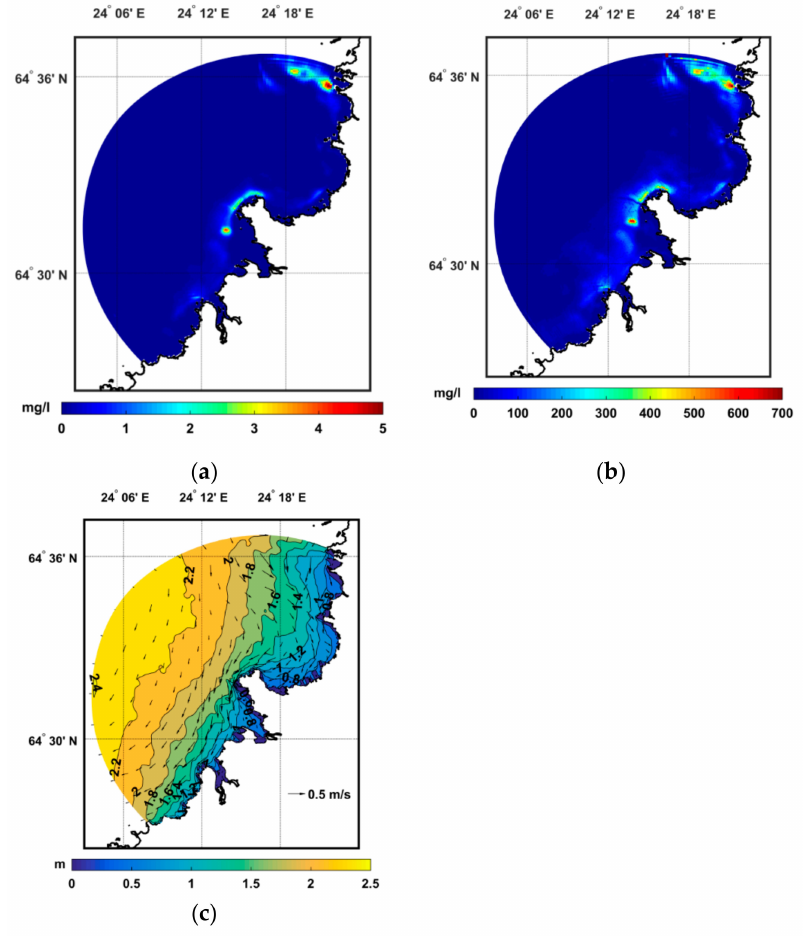
Figure 4. ( a ) Surface and ( b ) bottom suspended sediment concentration (SSC); ( c ) SWH and surface currents. Model results for 16 June